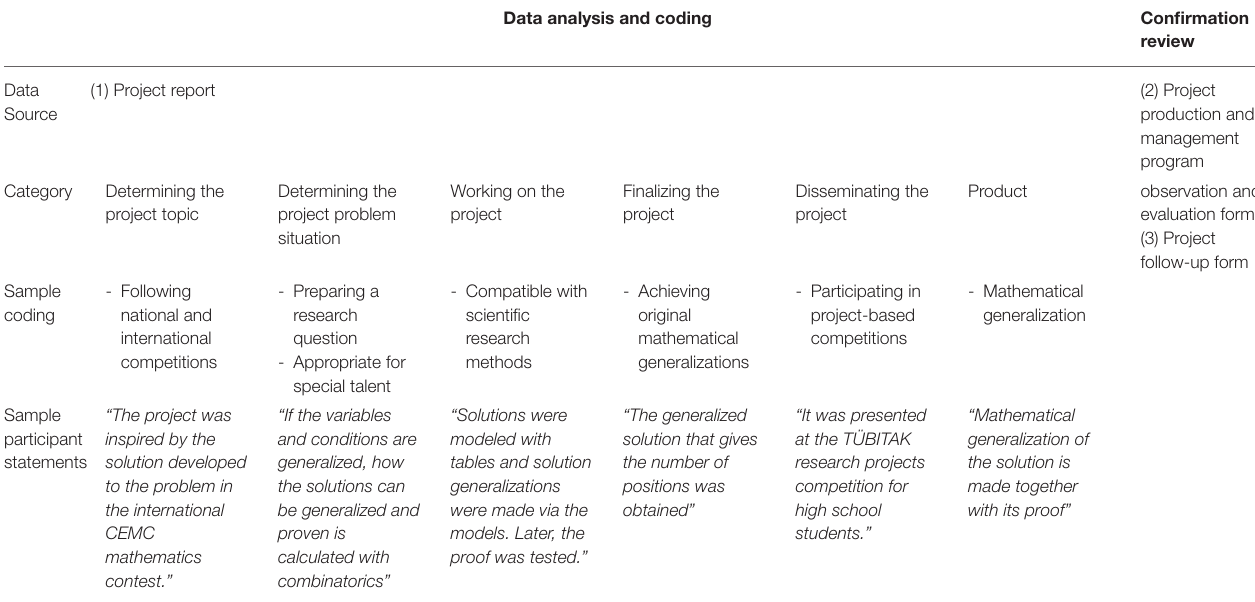
TABLE 3 | Sample data analysis and